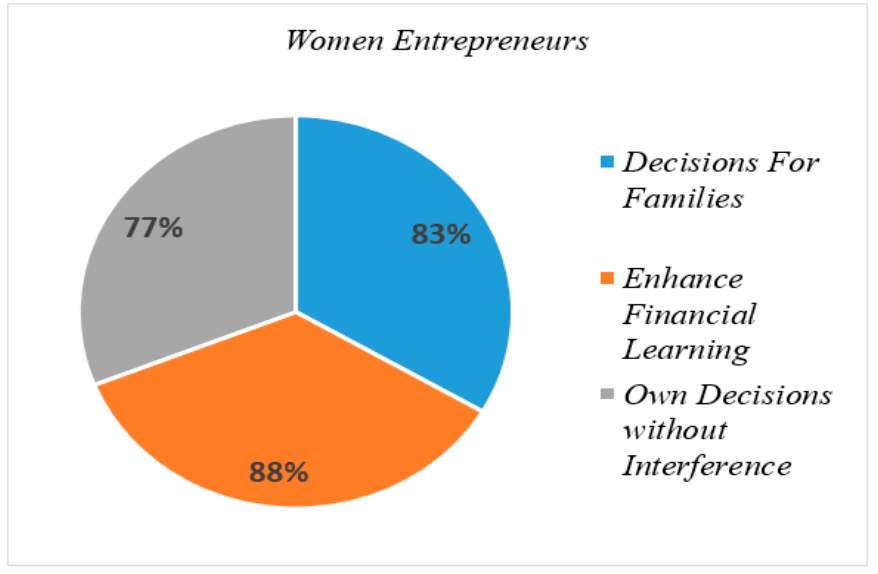
Figure 2. Women Financial Independence Illustrating Investment Attitude.